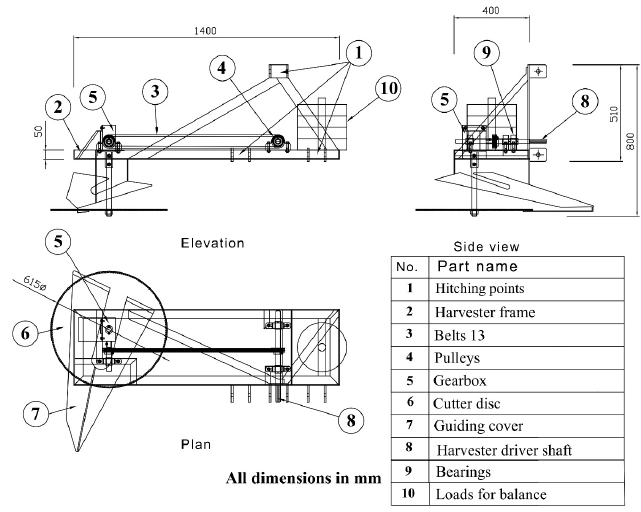
Figure 1. Fabricated sugarcane harvester prototype.